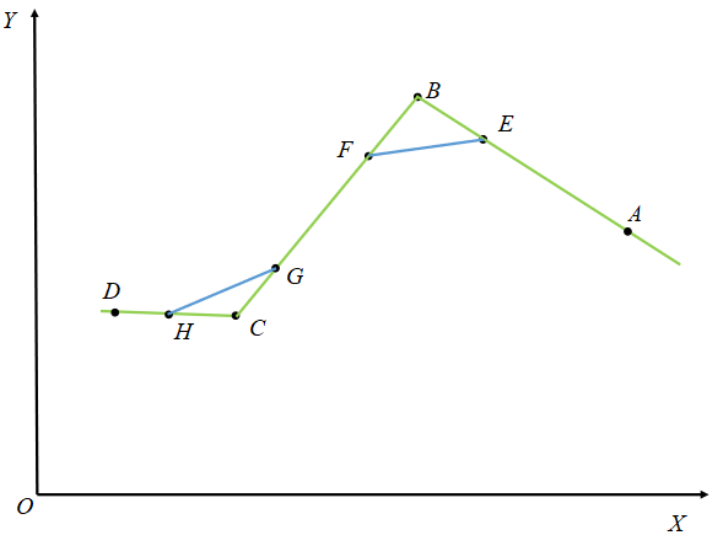
Figure 5. Schematic diagram of the trajectory correction method.